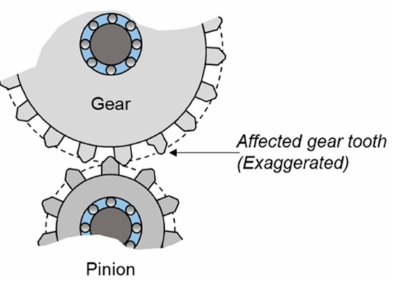
Figure 3. Diagram of the digital twin model.